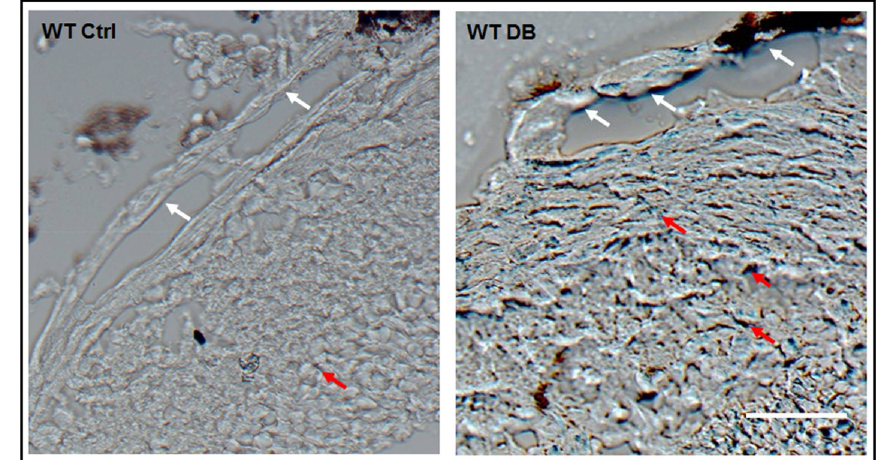
Figure 2. Diabetes induces senescence in retinal tissue. Senescence associated β -galactosidase (SA β -Gal) activity images of frozen retinal sections showing positive signal in cells of the large vessels (white arrows) as well as in the surrounding tissues (red arrows) of the central retina. Scale bar = 20 µ